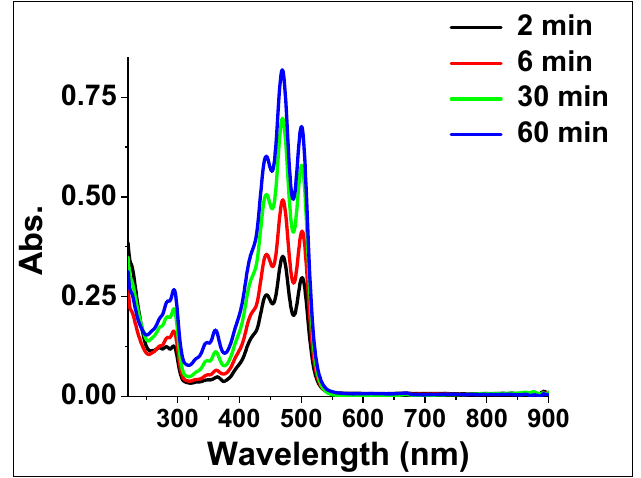
Figure 2. UV-vis absorption spectra of the extracts from the Pontica 102 skins in hexane, under conventional conditions at 60 °C.